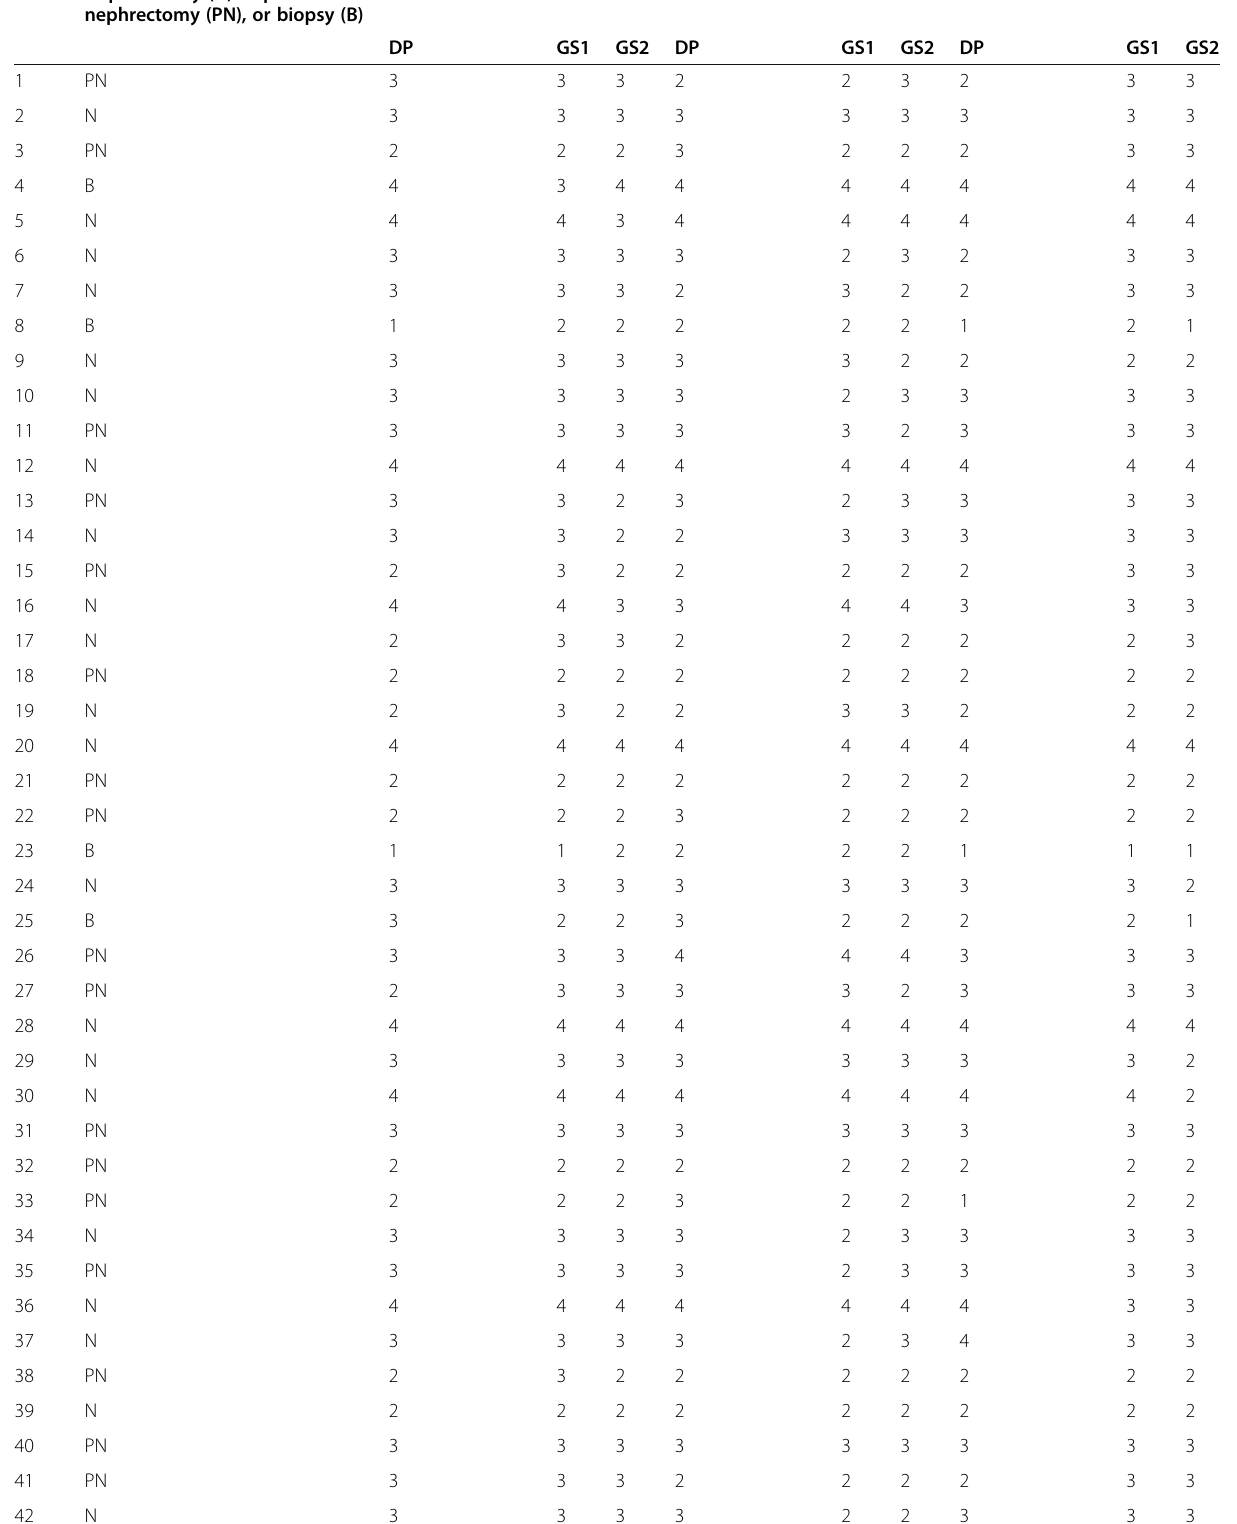
Table 1 Summary of all WHO/ISUP grading for all three pathologists on DP and on GS read 1 and GS read 2. Cases 1 – 50 = clear